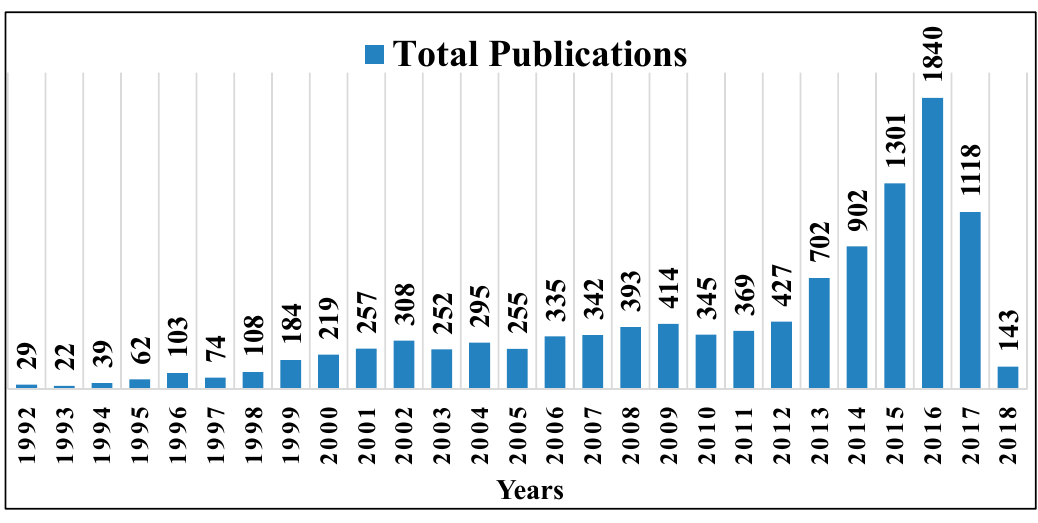
Figure 1. Neurocomputing (NC) publications/year distribution.